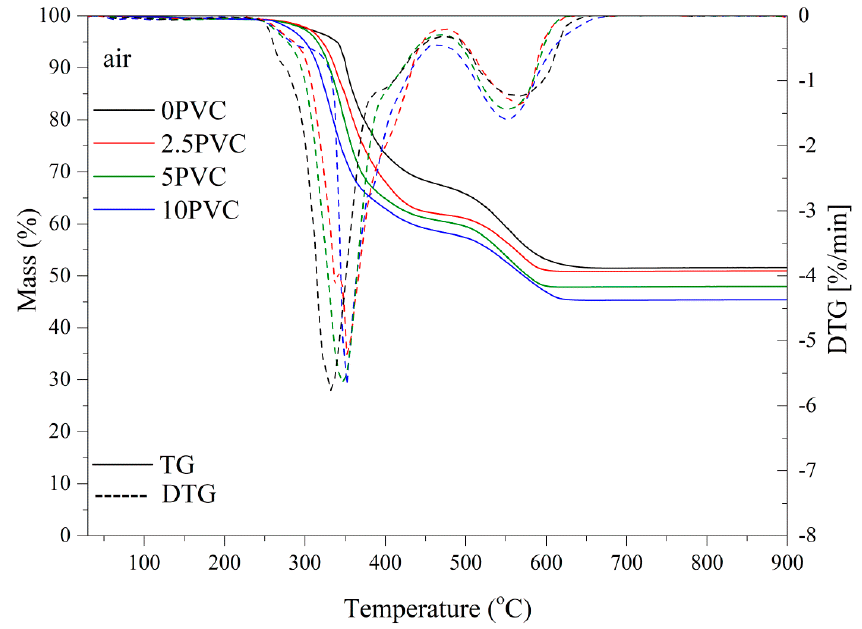
Figure 6. The characteristic thermogravimetric curves of the composites.